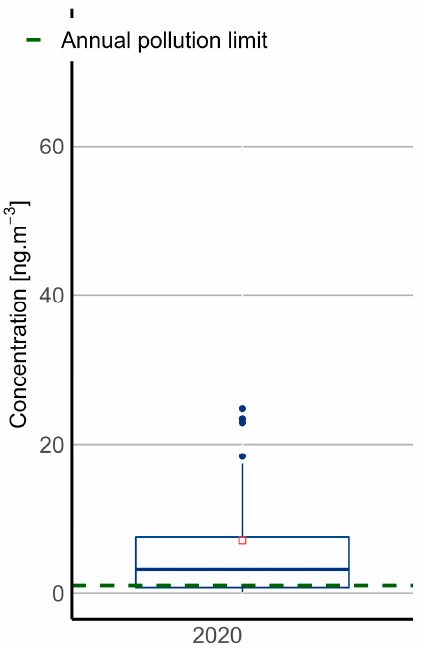
Figure 14. Boxplot of daily benzo[ a ]pyrene concentrations: Godów station, 2011–2020 (red squares indicate average concentrations; dashed line indicates the annual limit value for BaP).